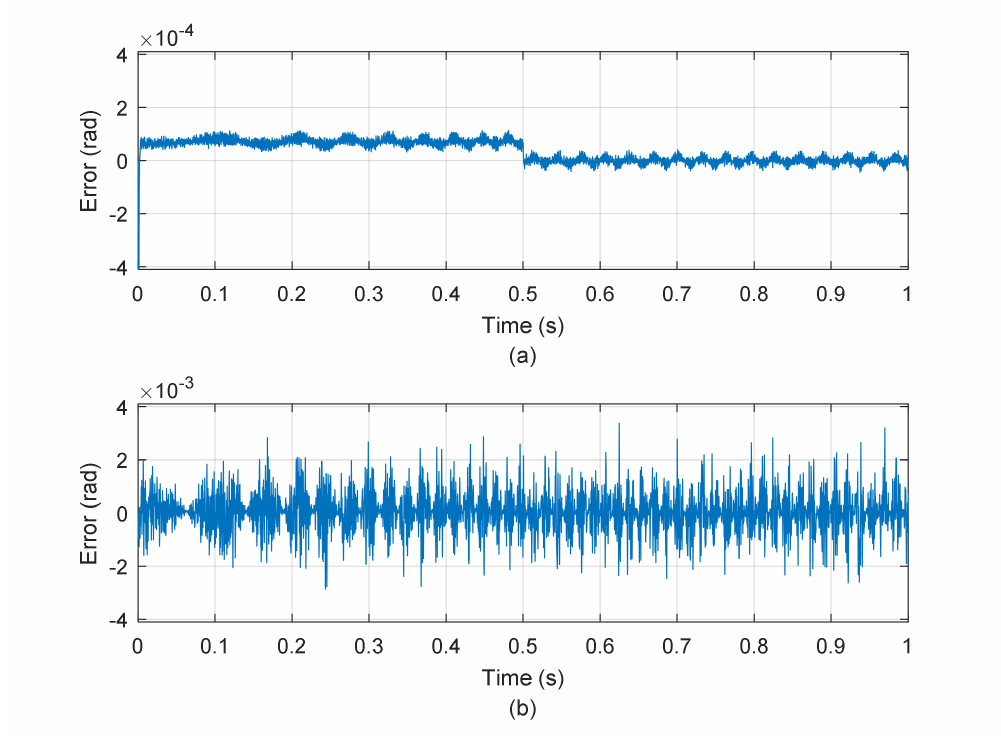
Figure 17. Experimental results for N p = 102, N c = 10, R w = 0.01. ( a ) Without noise; ( b ) with